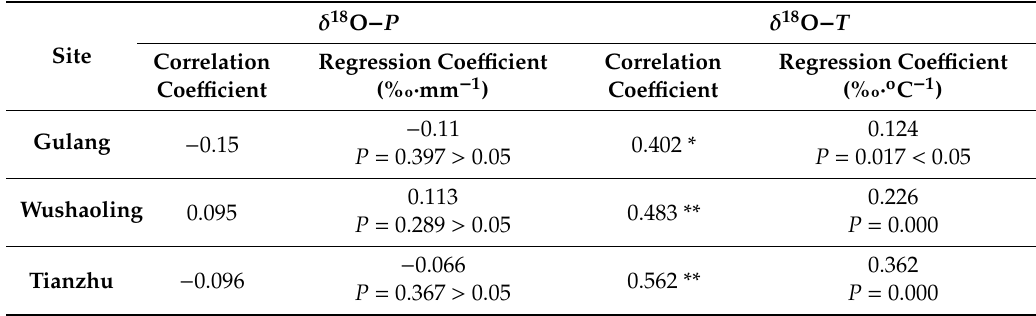
Table4. Therelationshipbetween δ 18 Oandprecipitationamount( P ),andbetween δ 18 Oandtemperature( T ).